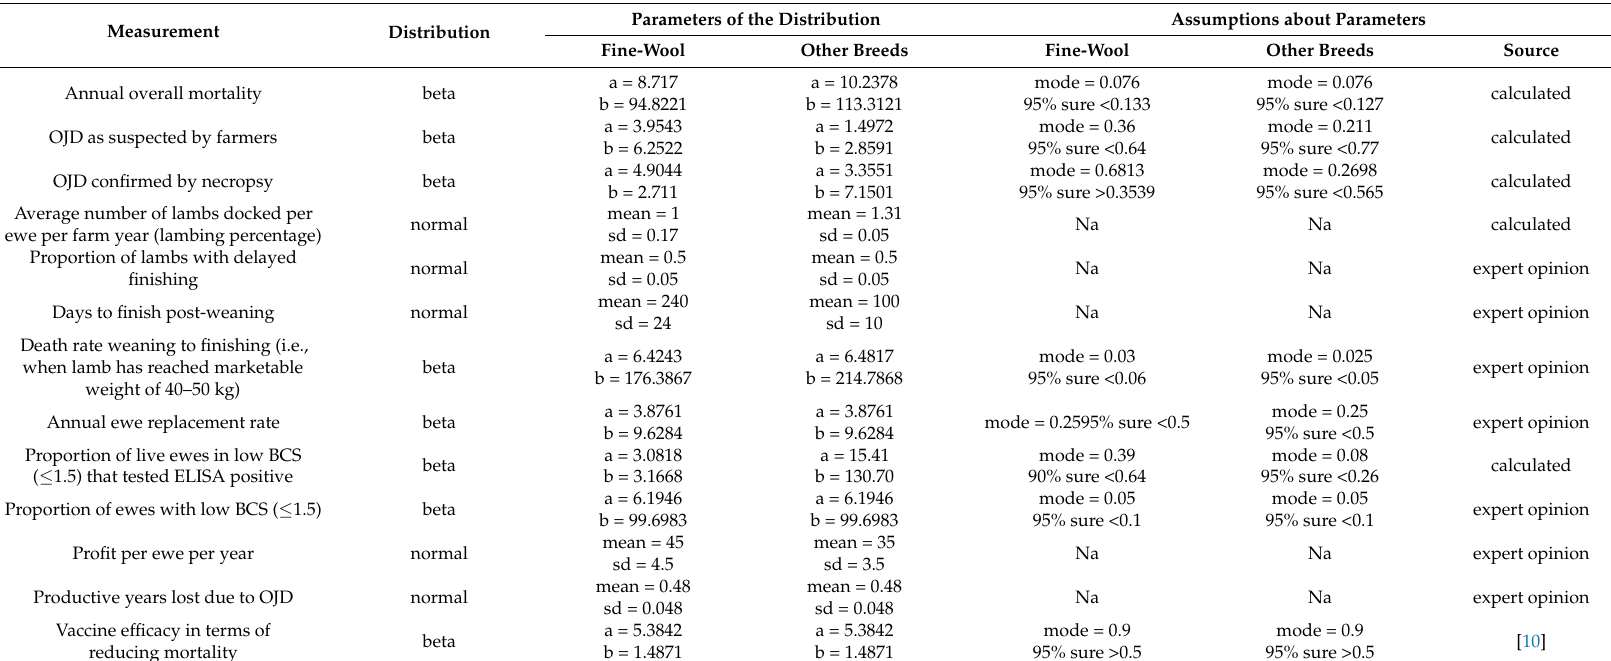
Table 2. Calculated and expert opinion based parameters and assumptions used for stochastic simulation modelling of OJD